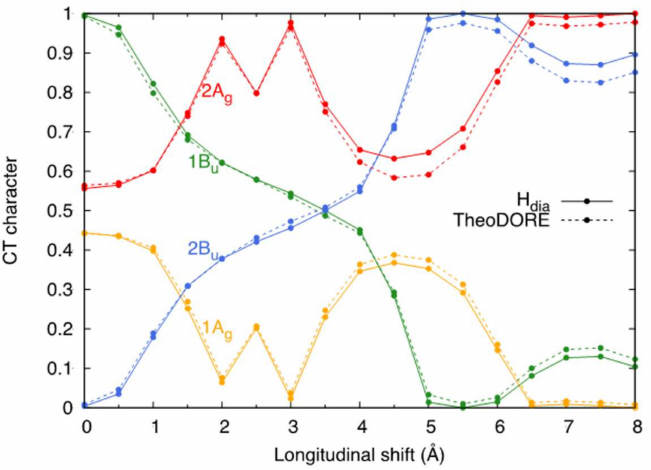
Figure 3. CT character of adiabatic singlet exciton states of PDI dimer along the longitudinal transla- tion coordinate determined with two different approaches (solid) using the procedure described in Section 2 and (dashed) using TheoDORE analysis tool